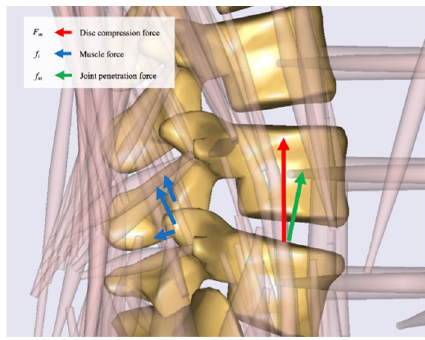
Figure 5. The magnified sagittal view of the lumbar spine in the musculoskeletal model. The green arrow indicates the penetration force exerted by an adjacent body segment. The blue arrow indicates the muscle forces acting on the vertebral body. The red arrow indicates the disc compression force, which was defined as the force perpendicular to the horizontal axis in the sagittal plane.